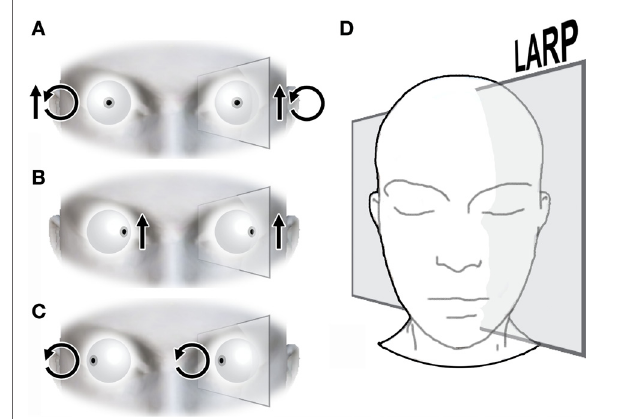
FigUre 3 | nystagmus characteristic of pc-BPPV . (a) A right pc-BPPV will present, after a Dix–Hallpike maneuver, with nystagmus accompanied by a quick phase that beats upward and rotates toward the affected ear (e.g., the upper pole of the eye rotates toward the right side). The eye rotates three-dimensionally in the LARP plane. From a frontal perspective, this is perceived as a mixed vertical and torsional nystagmus. (B) If the patient is asked to look to the left, thus aligning his gaze with the LARP plane, the pupil will beat upward in this plane, isolating the vertical component. (c) When the patient directs his gaze rightward, it becomes perpendicular to the LARP plane. In this position, the pupil is near the axis of rotation, therefore isolating the torsional component. (D) The eyes rotate on an axis parallel to the LARP